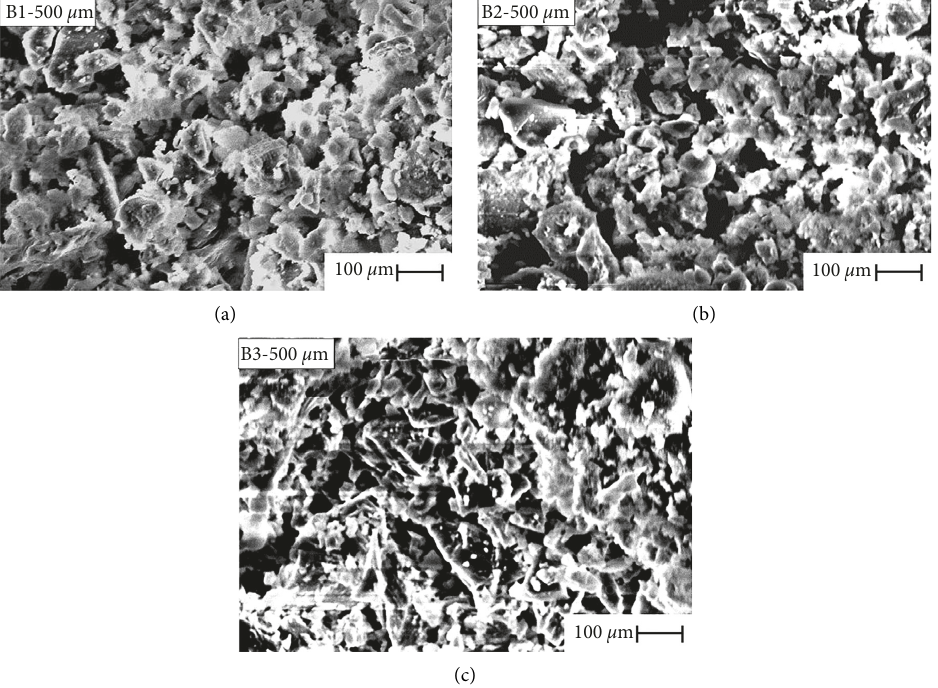
Figure 10: Surface microstructure of coating (B). (a) B1. (b) B2. (c)